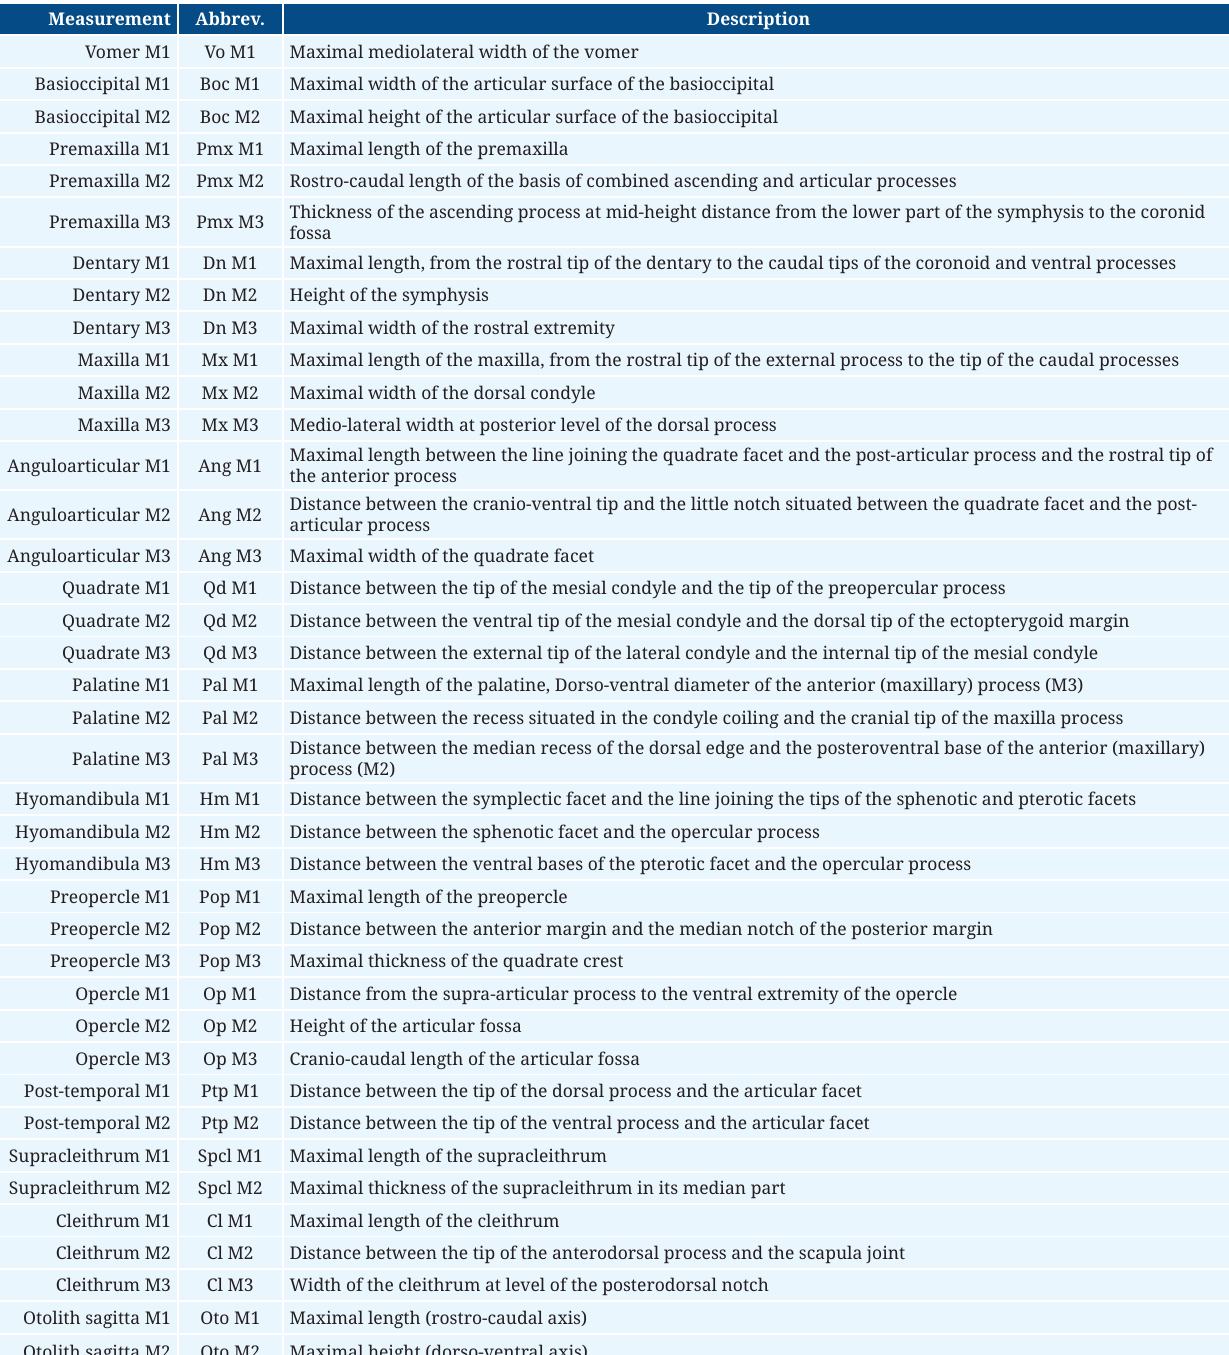
TABLE 1 | Lutjanus argentiventris bone measurements descriptions (see also Fig.